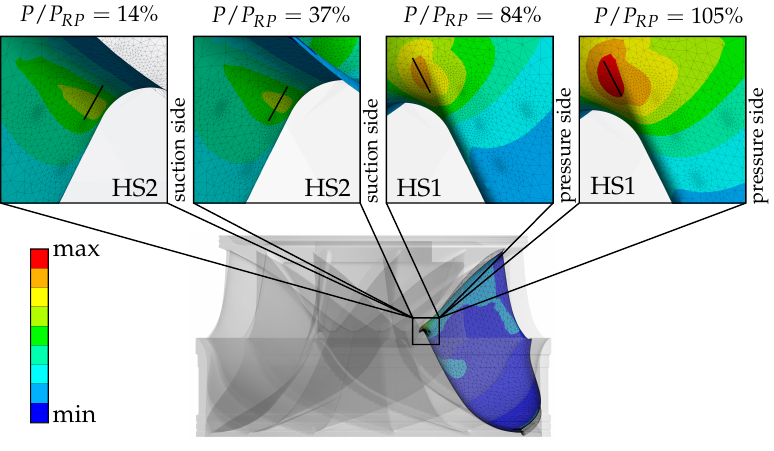
Figure 28. Change of Hotspot position according to different operating points.